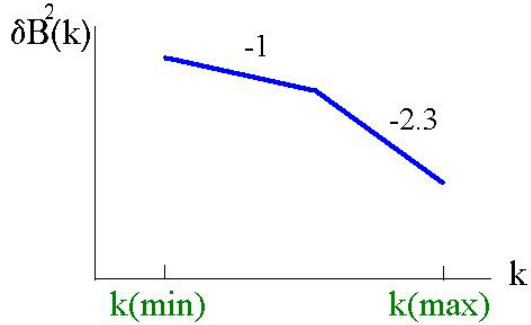
Fig. 2. The model spectrum of the magnetic fluctuations (axis have logarithmic scale). Magnetic field is normalized to B 0 ,k to 1/ L